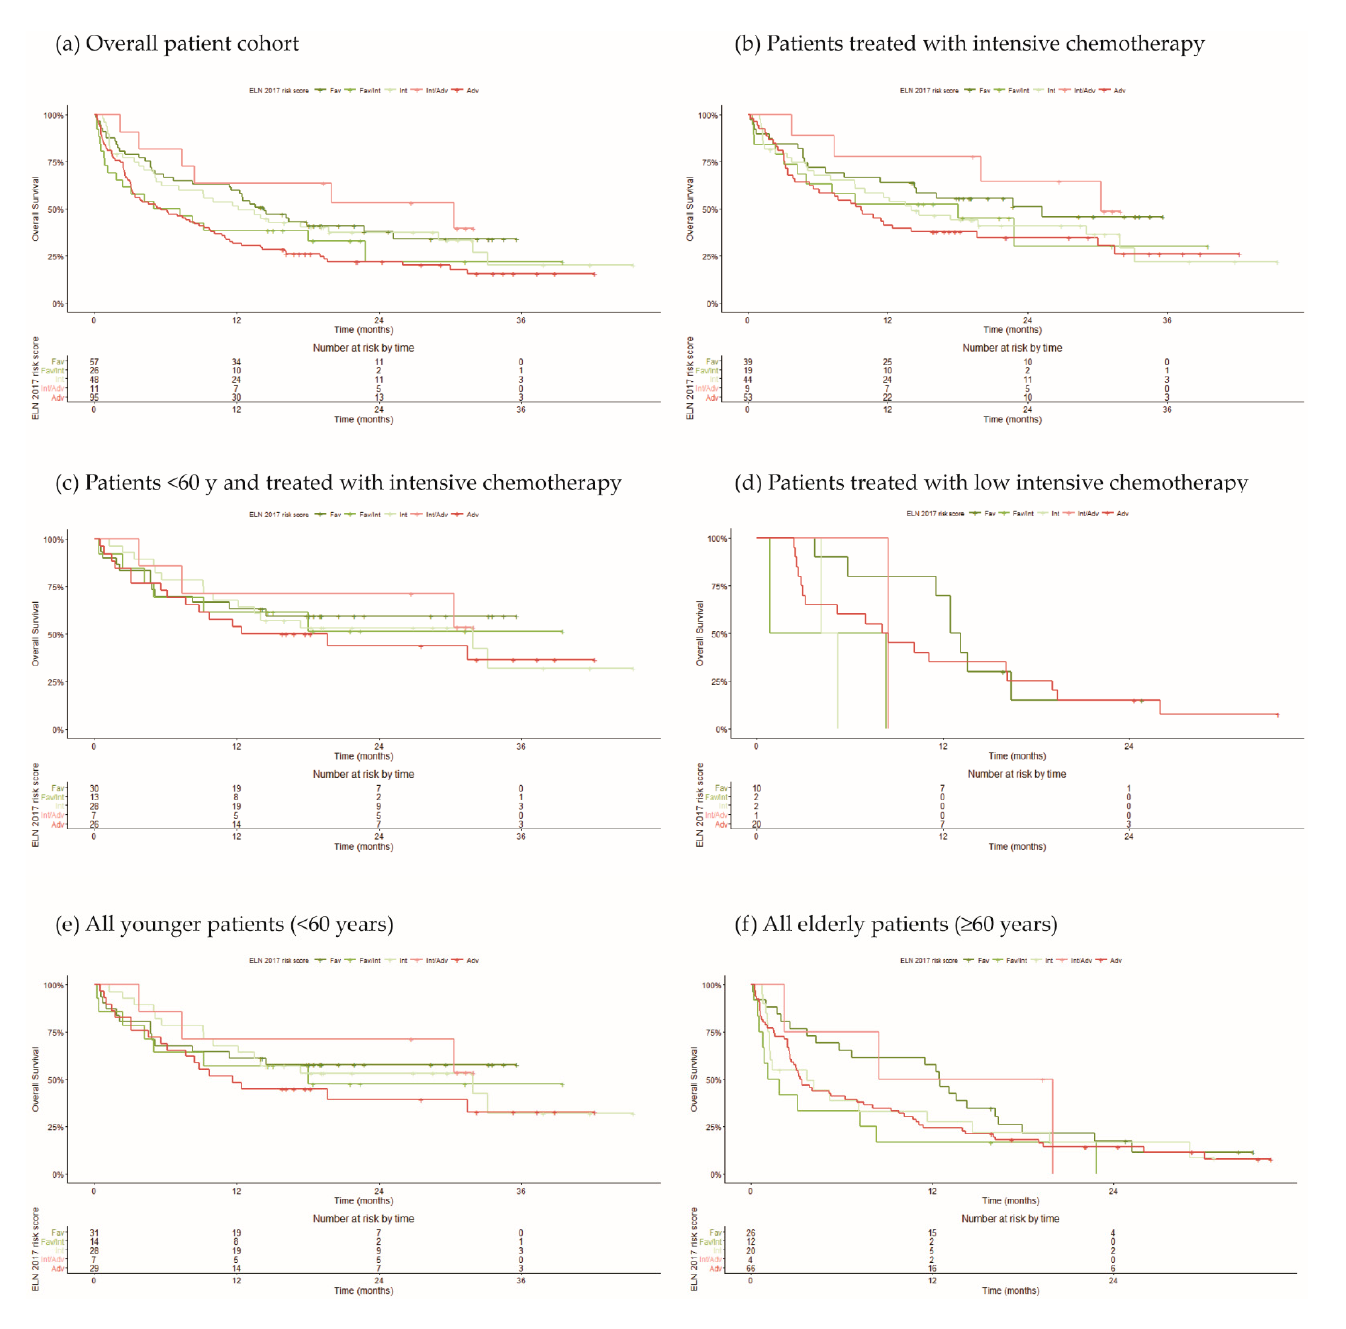
Figure 4. Kaplan–Meier curves for overall survival. Patients were stratified into favorable, intermediate, and adverse risk groups according to the ELN-2017 criteria. Due to the lack of information on the FLT3 -ITD allelic burden two additional groups were considered: favorable|intermediate and intermediate|adverse. ( a ) Overall patient cohort. ( b ) Patients treated with intensive chemotherapy. ( c ) Patients <60 y and treated with intensive chemotherapy. ( d ) Patients treated with low-intensive chemotherapy. According to age, in younger (<60 years) ( e ) and elderly ( ≥ 60 years) patients ( f ).